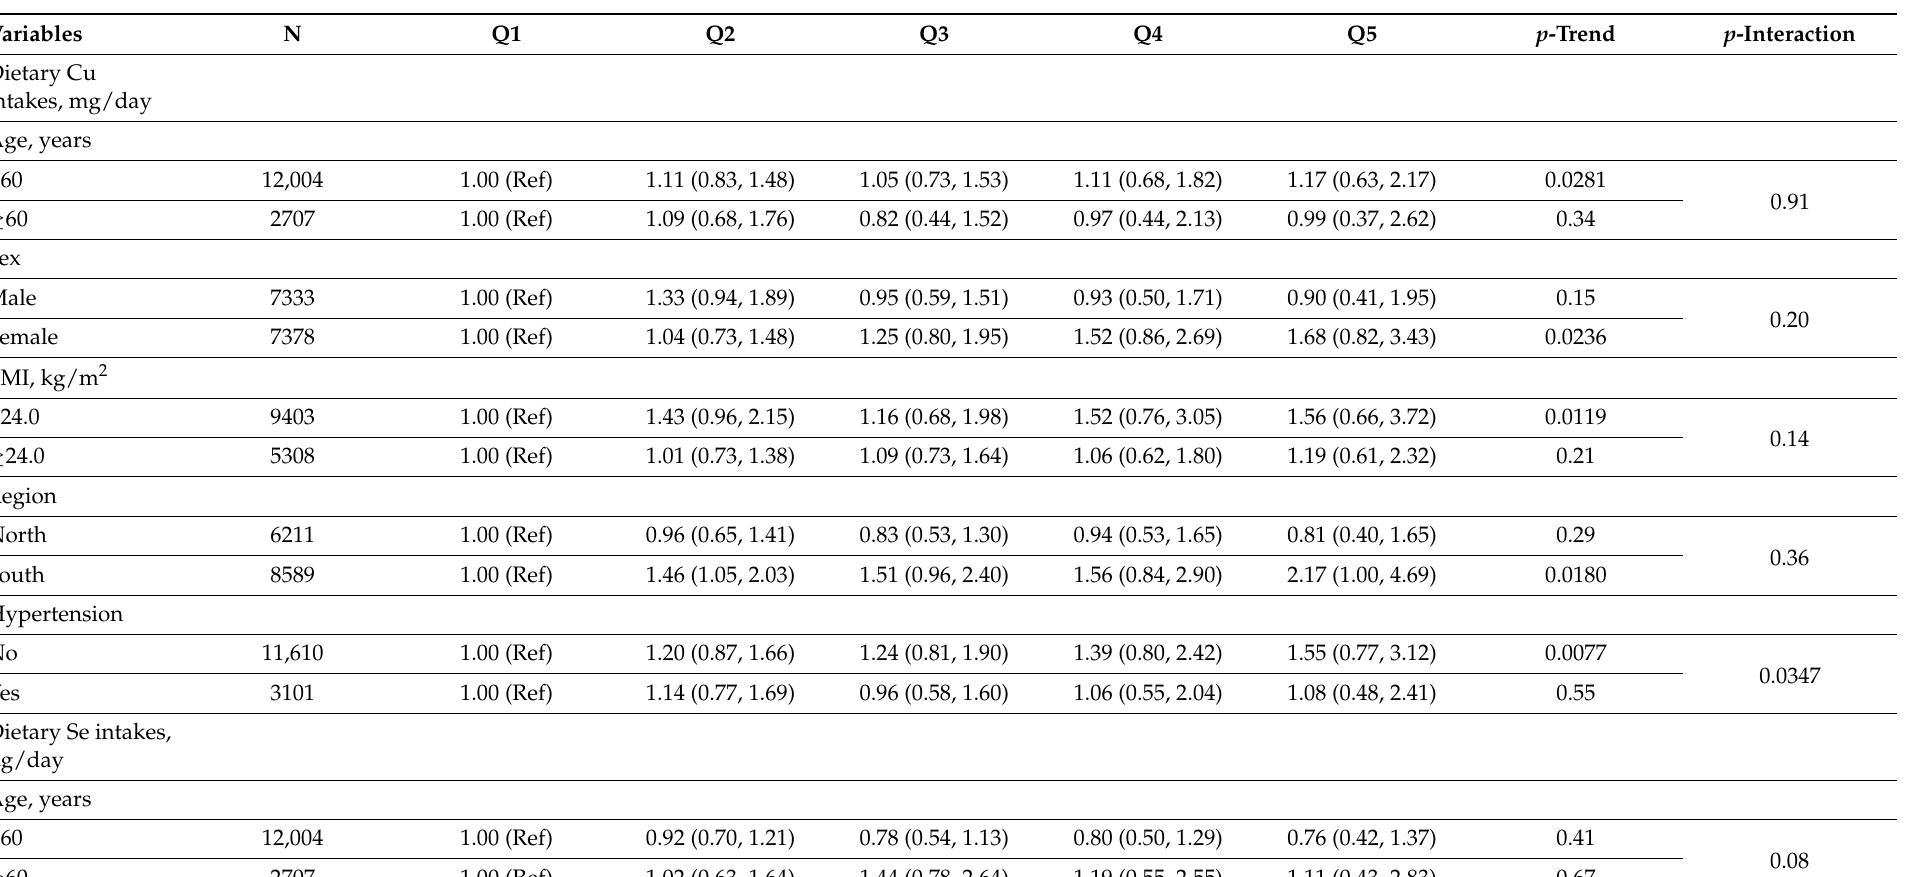
Table 4. HRs and 95% CIs for T2DM risk associated with dietary Cu and Se intakes in 14,711 Chinese adults of the China Health and Nutrition Survey, 1997–2015, stratified by age, sex, BMI, and baseline hypertension history 1